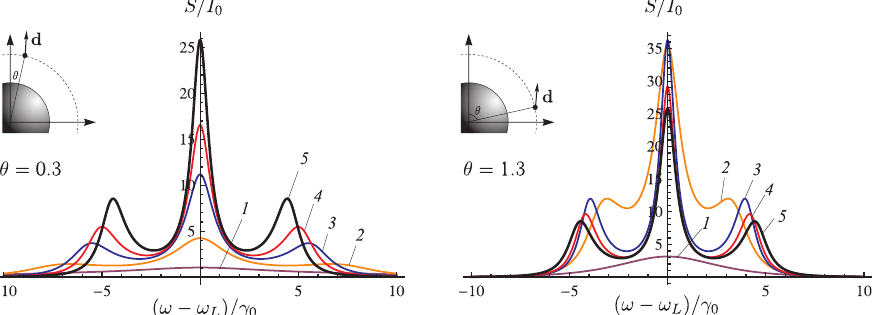
Figure 9. Resonance fluorescence spectra (normalized to I 0 ) of a two-level QE located near a nanosphere with a radius of a = 20 nm for two positions of the QE: θ = 0.3 rad ( left ) and θ = 1.3 rad ( right ). The QE–NP distance from the surface is 5 nm (curve 1), 10 nm (2), 20 nm (3), and 30 nm (4). Curve 5 refers to QE in free space. E 0 = 2000 V/m, λ = 632.8 nm, γ 0 = 20